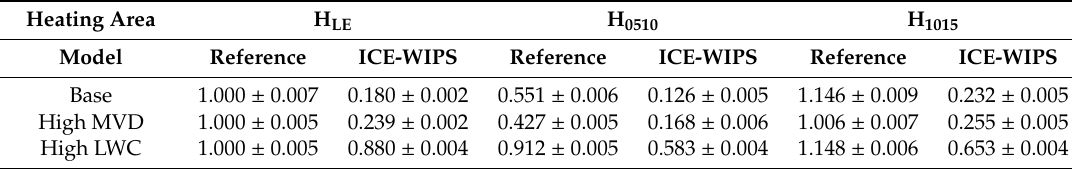
Table 4. Summary of normalized power consumption per unit area in demonstration test.